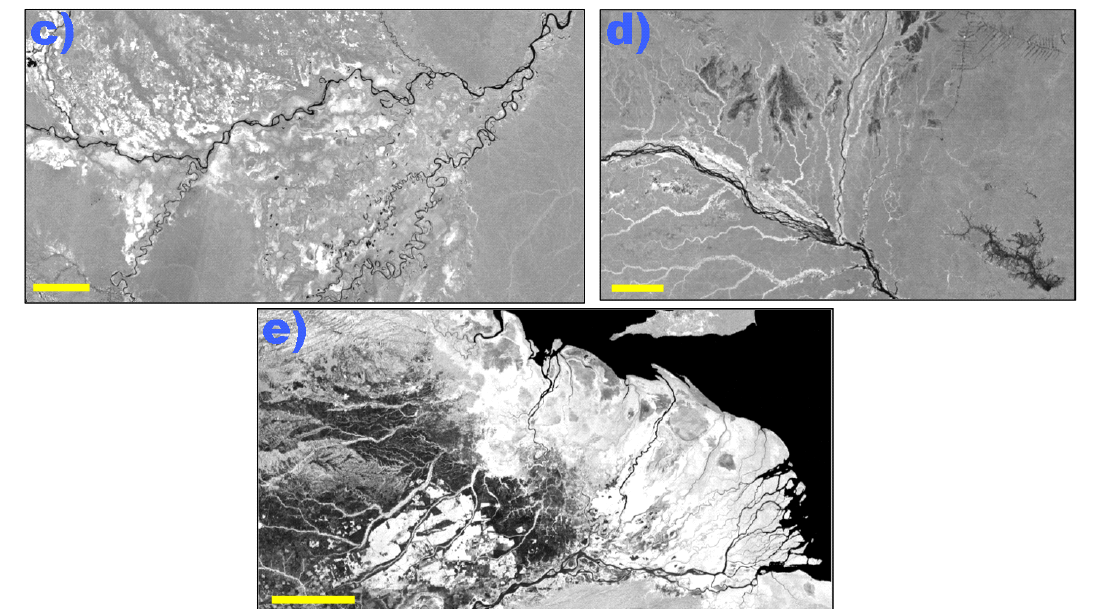
Figure 4. Yellow scale bar corresponds to 50 km, and the location of each sub-figure is shown in Figure 3. Generally, we may associate the brighter areas as caused by double-bounce reflections in inundated vegetation areas or urban regions. Water and bare soil appear dark and forest areas are medium-grey shades. Locations are indicated in Figure 3. ( a ) Noel Kempff National Park, Bolivia; ( b ) Deforestation near the city of Rio Branco, Brazil (bright area at center) and inundated Iquiri River floodplain; ( c ) Pacaya-Samiria Reserve, Peru; ( d ) middle Rio Negro; and ( e ) Orinoco Delta. © JAXA,